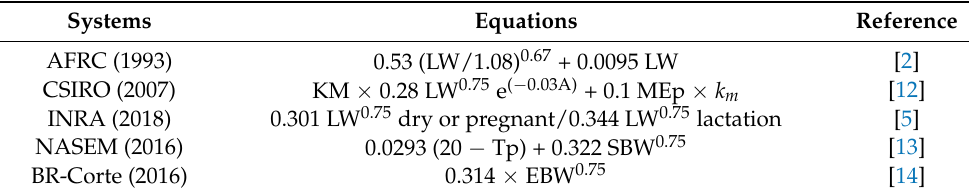
Table A4. Equations used to calculate maintenance requirements in suckler cows (NE m ) *.